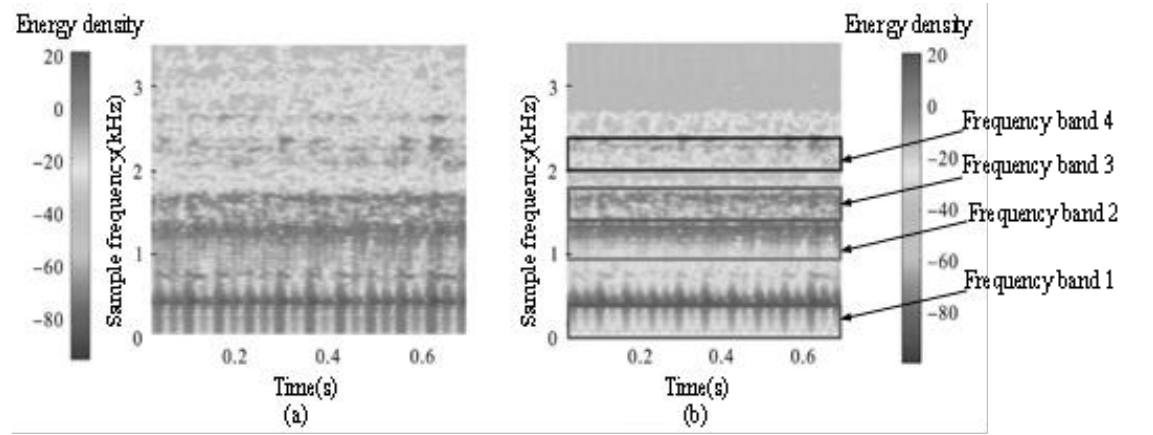
Figure 6. Time – frequency diagram of the raw signal and signal after VMD. ( a ) Original signal. ( b ) After VMD processing.